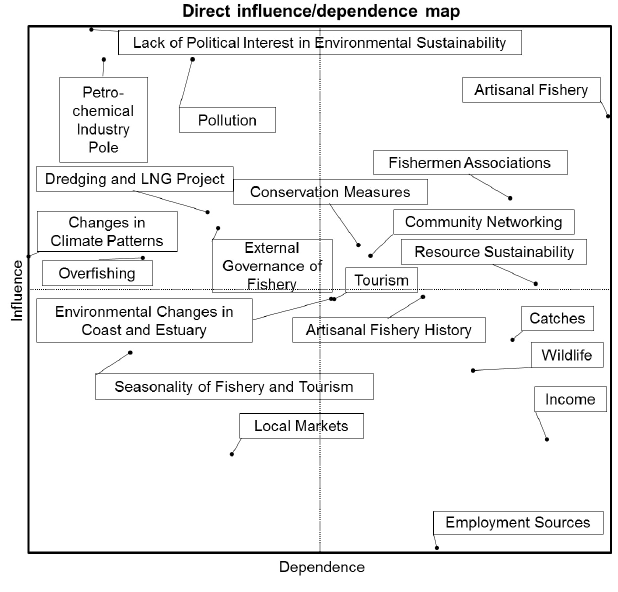
Fig. 7 . Influence/dependence map for direct influences in